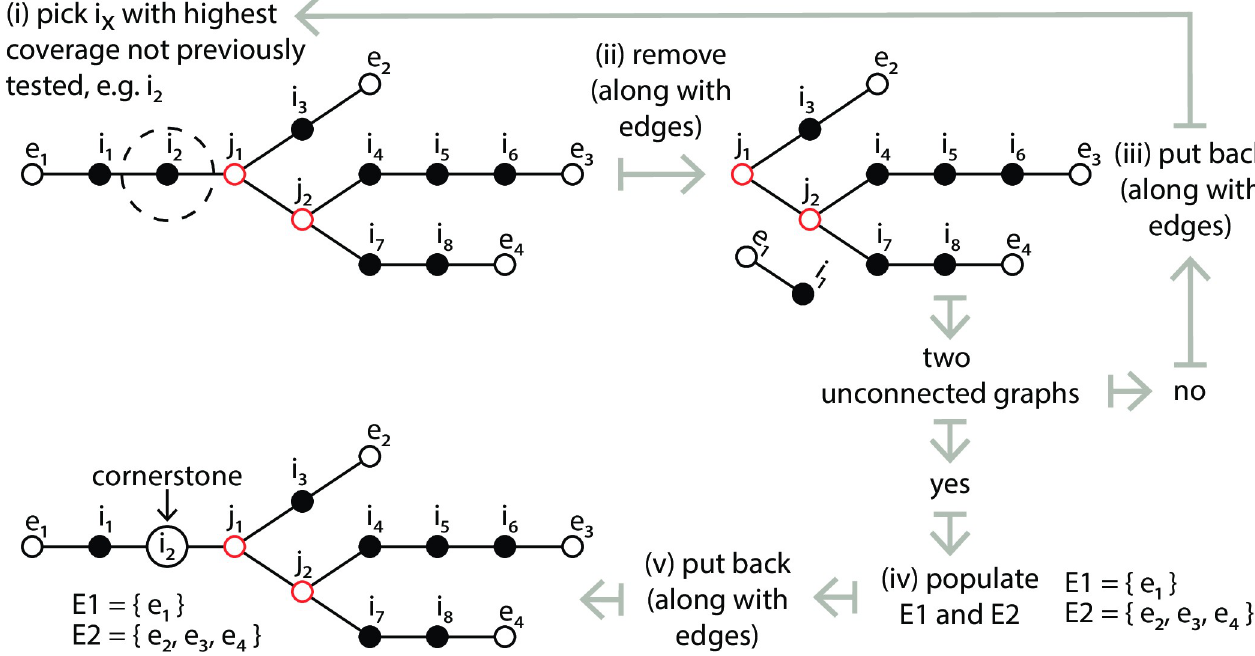
Fig 2. Identification of the cornerstone node and population of sets E1 and E2. Node indicators are the same as those used in Fig 1. Steps (i) to (v) outline the procedure to select the cornerstone node and subsequently to populate sets E1 and E2.